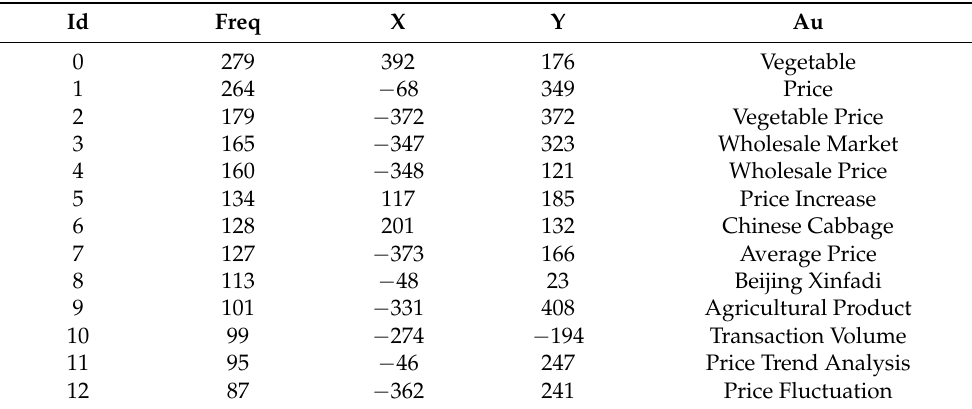
Table 4. Ranking of CNKI Co-occurrence